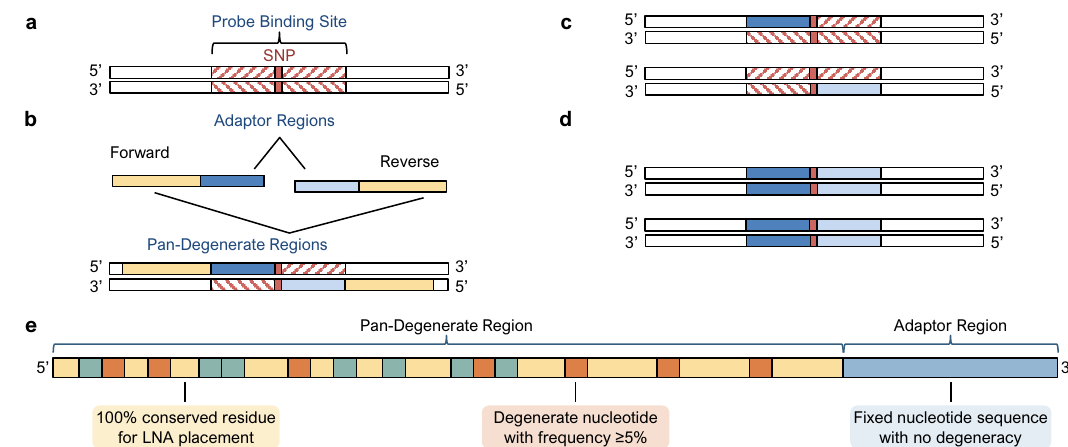
Fig. 1 Overview of PANDAA method and primer design. a Heterogeneous genomes contain single-nucleotide variants within the probe-binding site that prevent the use of probe-based qPCR for DRM discrimination. b PANDAA primers overlap with the probe-binding site, adapting the nucleotides proximal to the DRM of interest that would otherwise abrogate probe hybridization. c , d As qPCR proceeds, the newly generated amplicon will contain probe-binding sites fl anking the DRM that are perfectly complementary to the probe. e PANDAA primers contain two key features: a 3 ′ ADR that is matched to the probe-binding site and a pan-degenerate (PDR) region that incorporates the nucleotide degeneracy observed in the primer-binding site of the target. The PDR accounts for the high degree of variability in primer-binding sites. LNA bases at 100% conserved positions in the PDR offset the thermodynamic instability of mismatches between the primer ADR and the